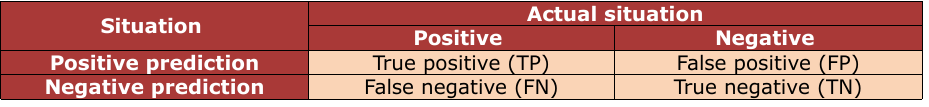
Table 2. The confusion